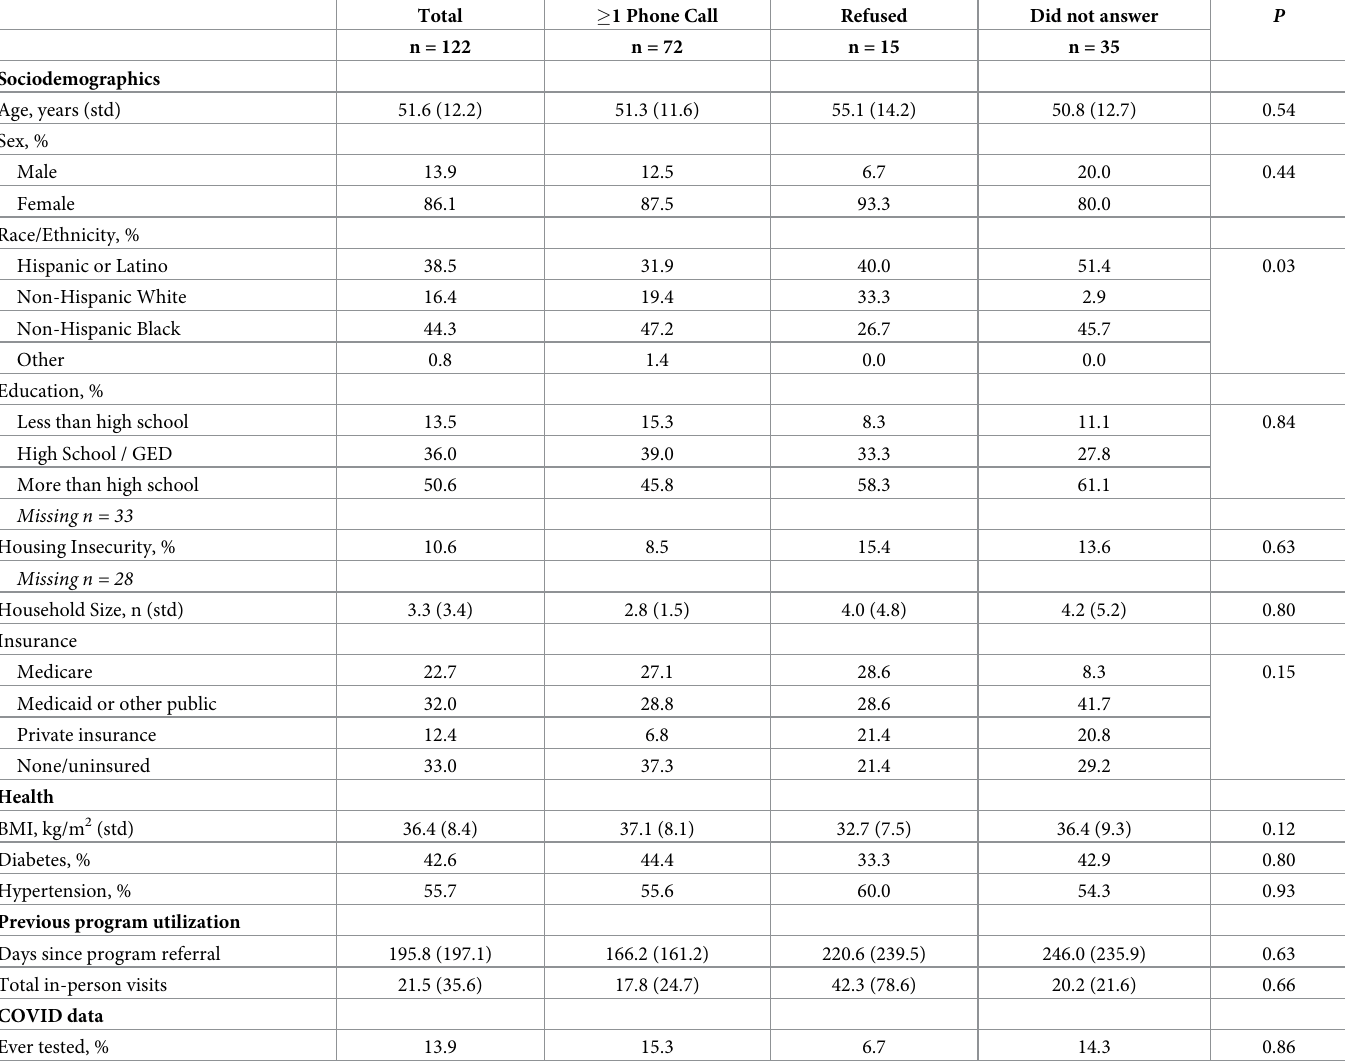
Table 1. Characteristics of patients with a Wellness Center phone call, by answer status, n =